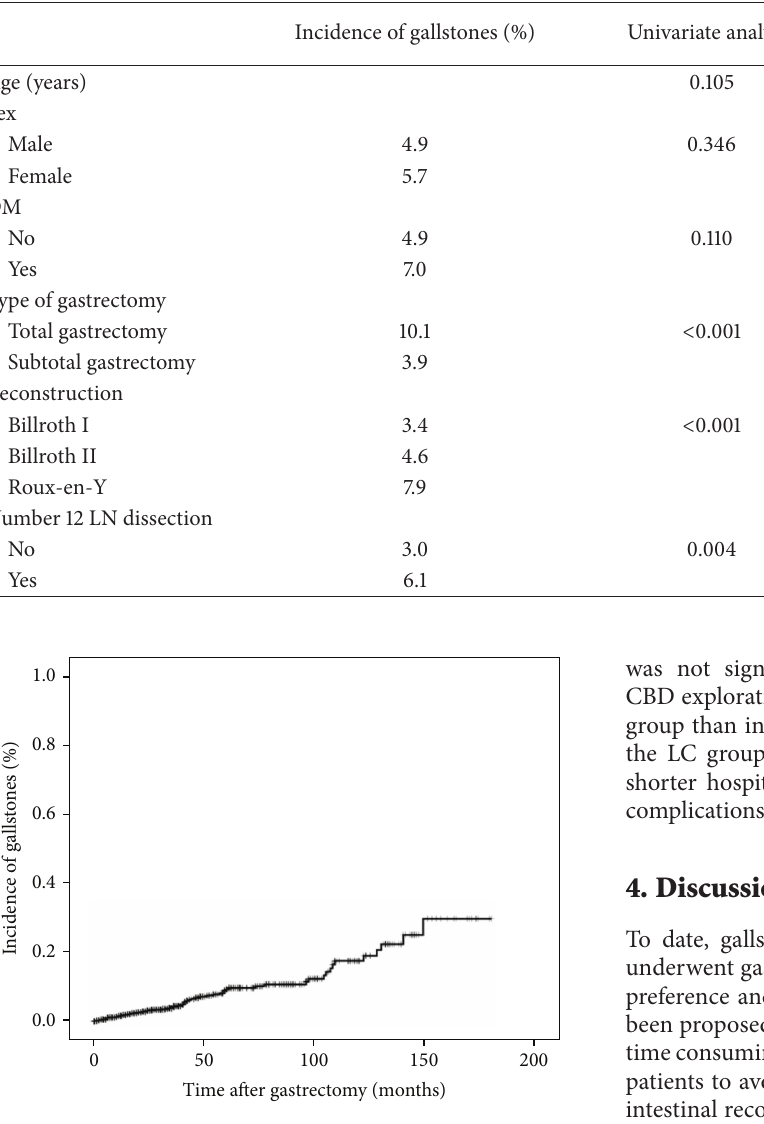
Figure 2: Incidence of gallstones after